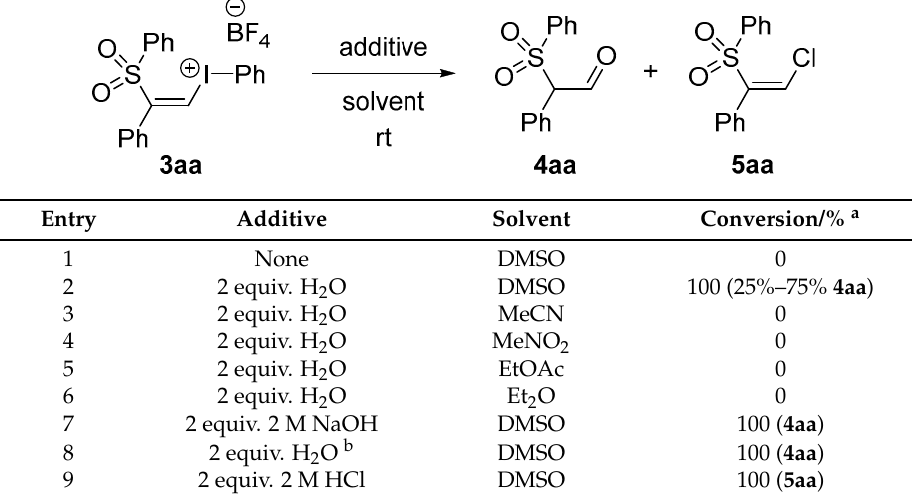
Table 1. Effect of solvent and additives on reactivity of iodonium salt 3aa .